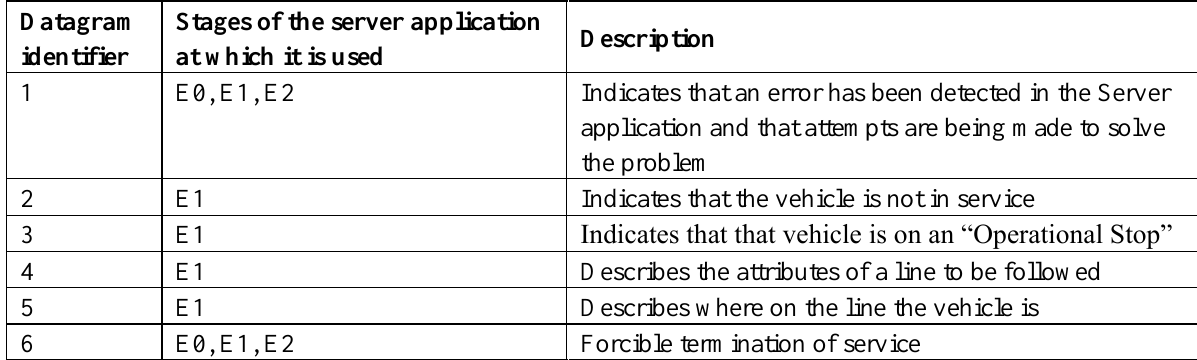
Table 3. List of